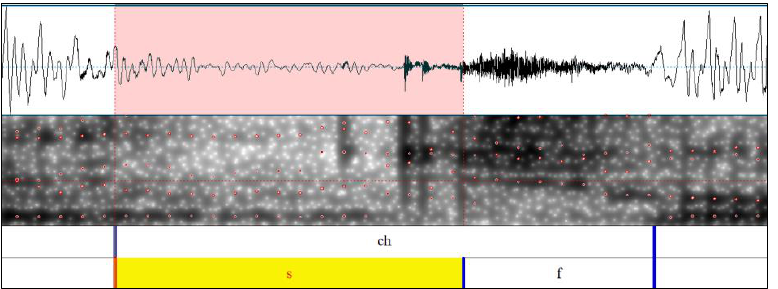
Figure 1. Transcription of the interview in PraatAlign. Male speaker (UT008). The audio for this